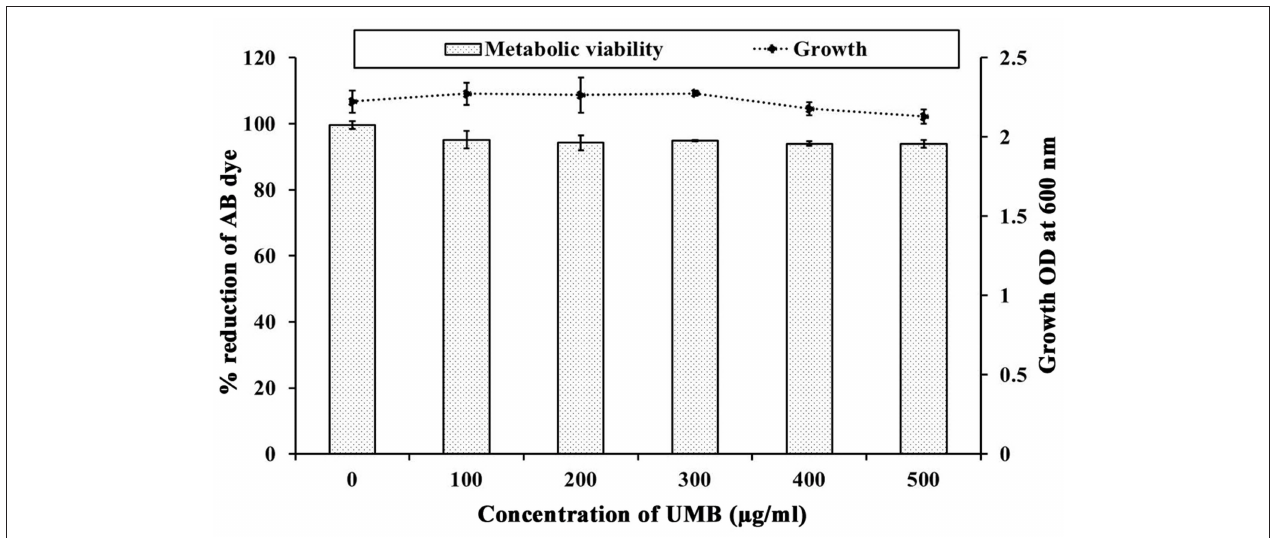
FIGURE 2 | Influence of UMB on growth and metabolic activity of MRSE. Line graph indicates the effect of UMB on MRSE growth assessed using microbroth dilution assay. Bar graph denotes the effect of UMB on metabolic activity of MRSE tested using alamar blue assay. Error bars indicate standard deviations.